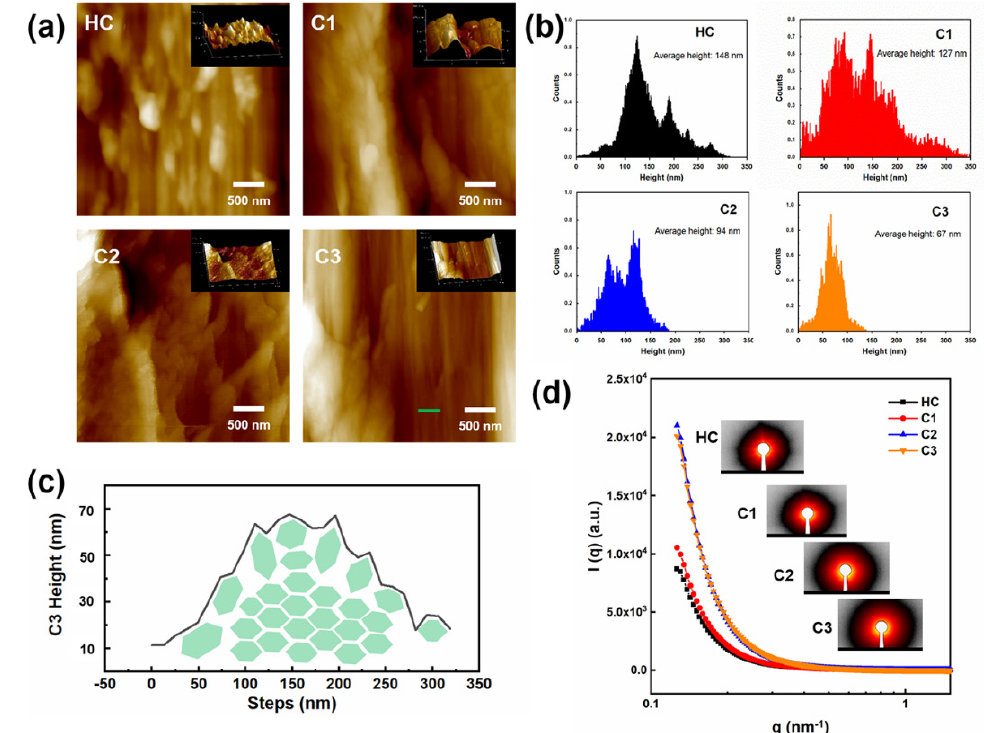
Figure 2. AFM images ( a ) and the average height calculations ( b ) of the holocellulose slices before and after HTP; schematic model of microfibrils based on step scanning from C3 AFM image ( c ); SAX patterns and corresponding 2D images ( d ).